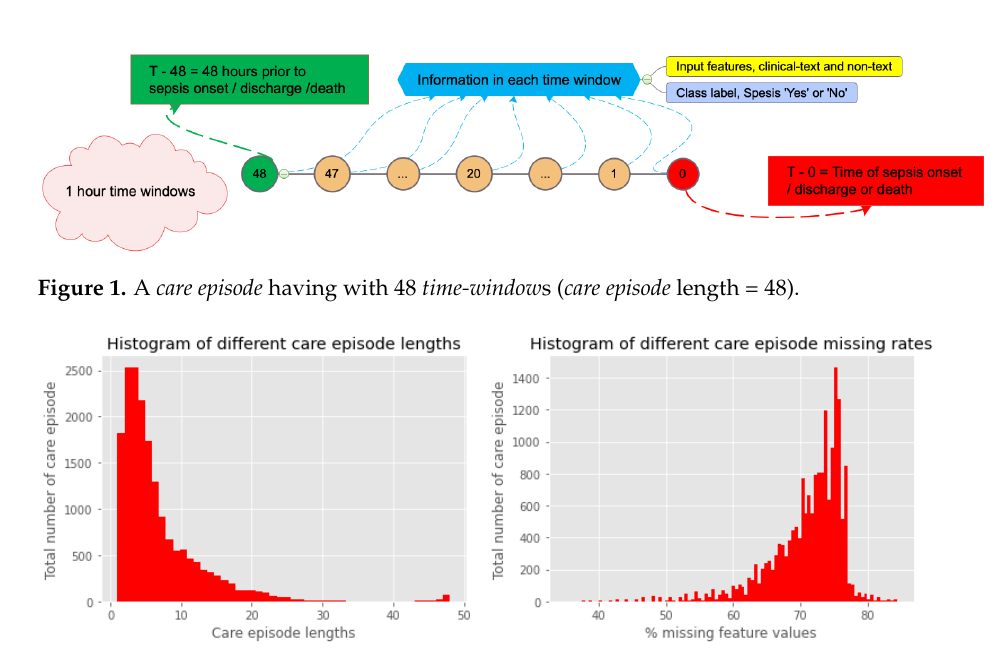
Figure 2. Histogram of different care episode lengths ( left ) and missing rates ( right